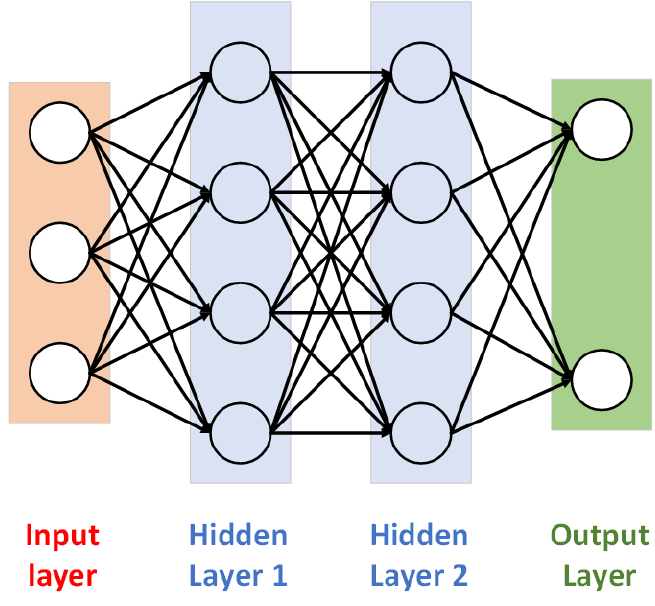
Figure 3. Node in an Artificial Neural Network.